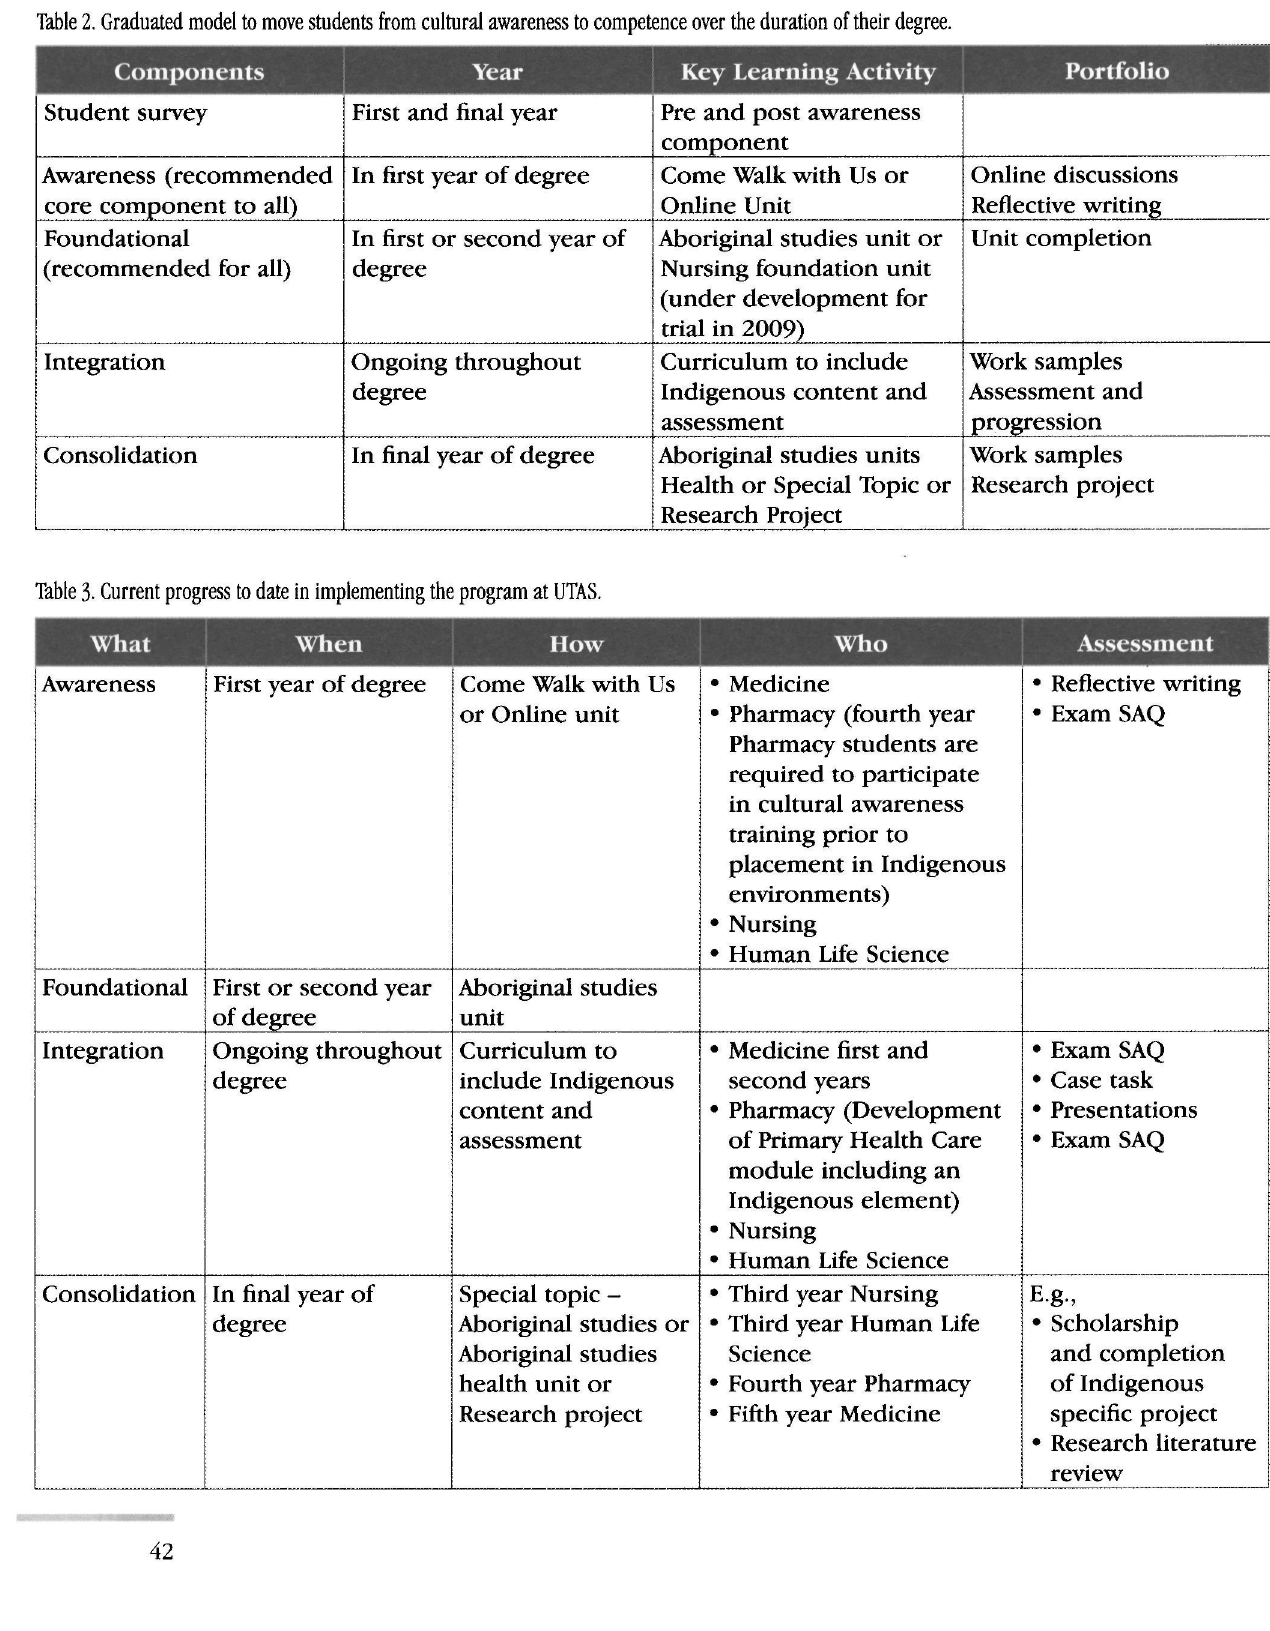
Table 3- Current progress to date in implementing the program at UTAS.